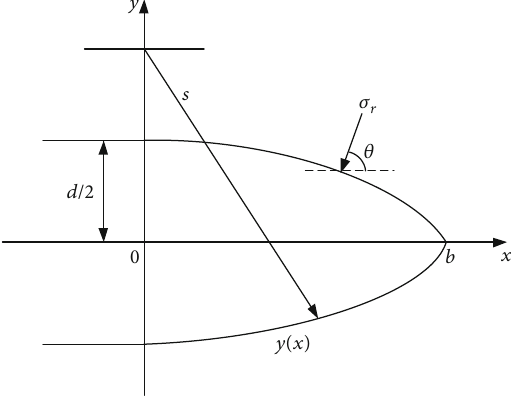
Figure 3: Diagram of an ogive-nosed